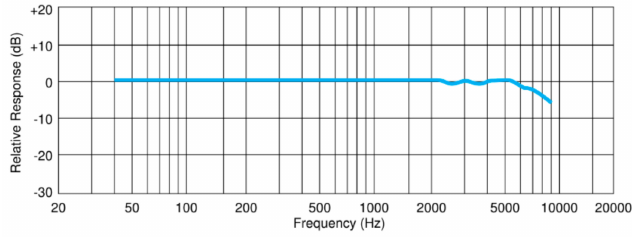
Figure 2. Panasonic WM 63-PR microphone frequency response.